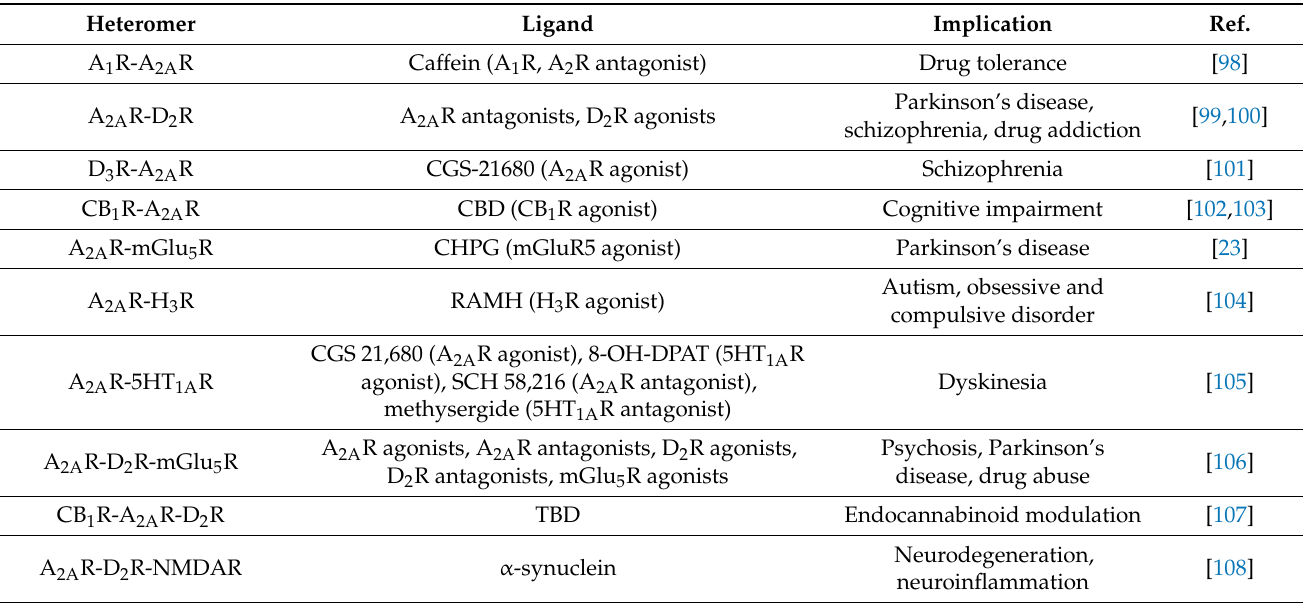
Table 2. A 2A R complexes with other GPCRs and their